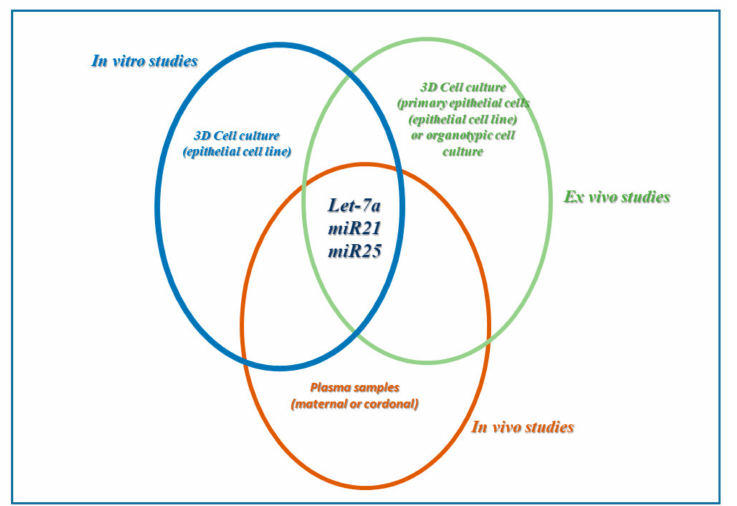
Figure 6. Experimental approach to identify molecular biosensors of airway disease. “In vitro/ex vivo” studies obtained with experimental approach performed with 3D cell cultures of bronchial epithelial cells (cell line and primary cells); Integrated approach obtained including “in vitro”, ex vivo” 3D cell cultures of bronchial epithelial cells and “in vivo”